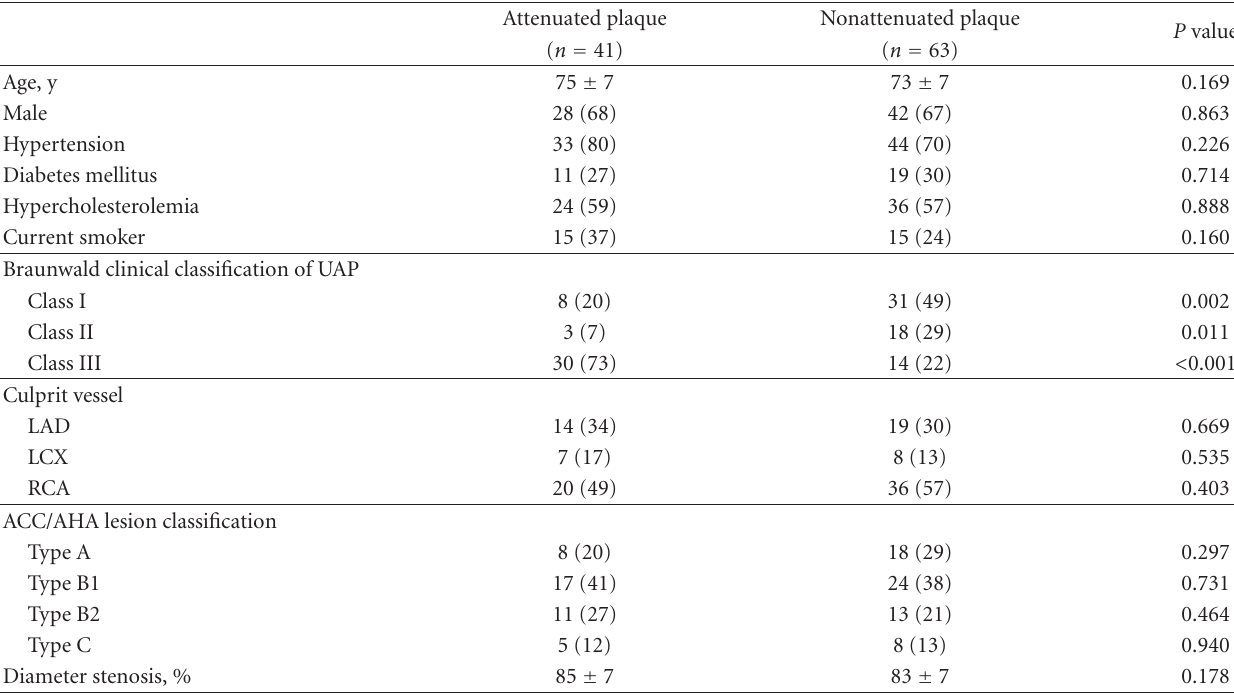
Table 1: Clinical and angiographic characteristics.